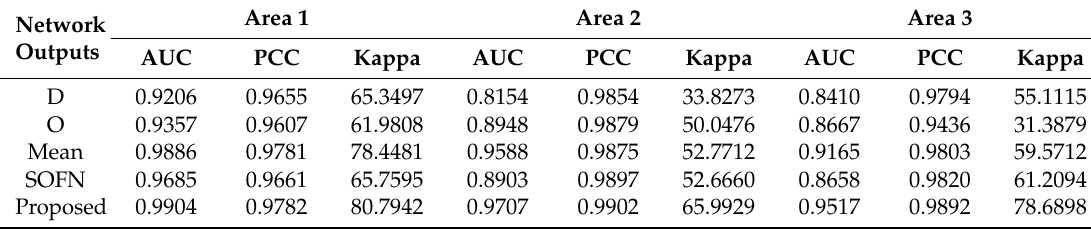
Table 3. Quantitative assessment of single output decision and proposed